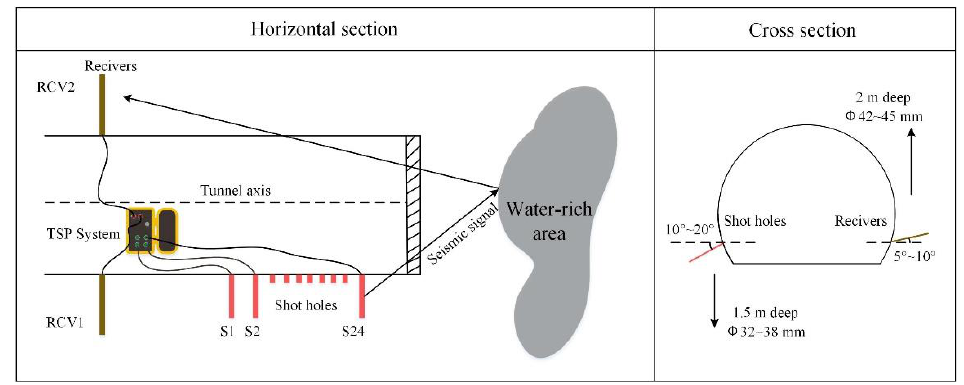
Figure 2. Schematic diagram of the TSP observation system.